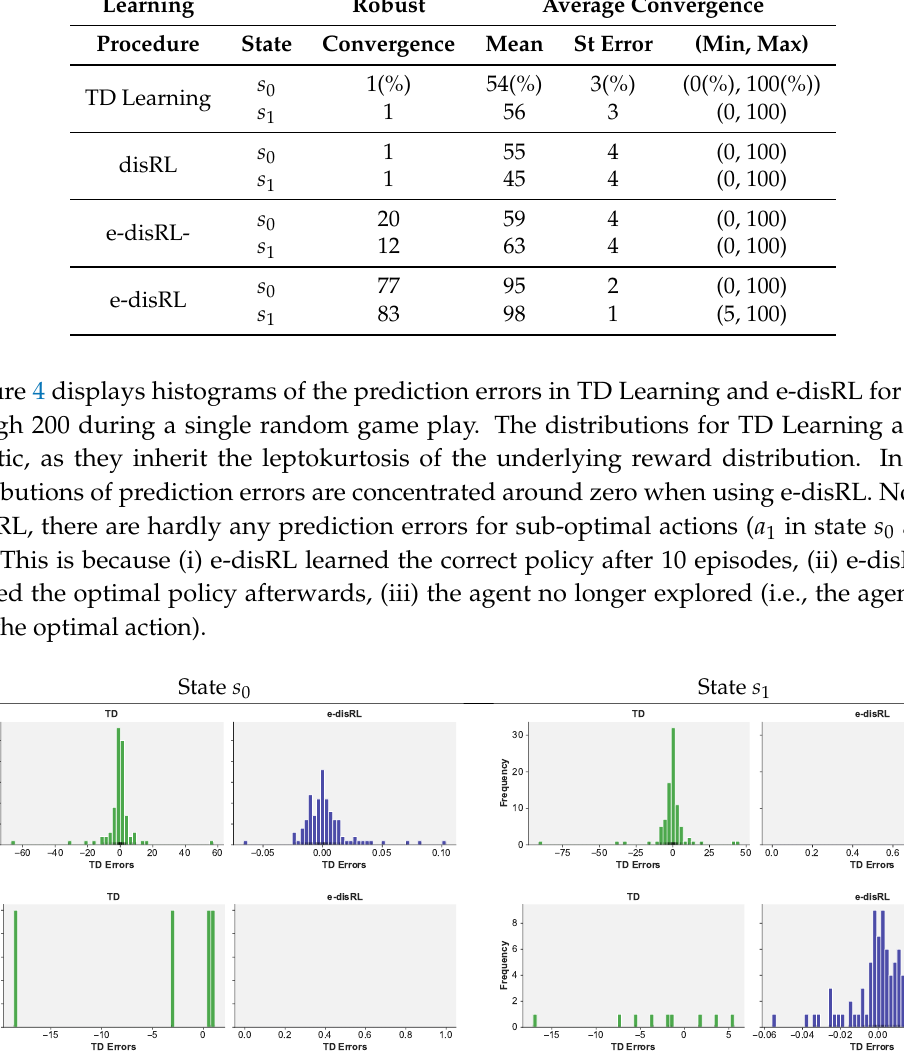
Figure 4. Prediction error histograms for all trials during episodes 11-200 of a single game play, TD Learning and e-disRL. There are no observations, and hence, no histograms, for e-disRL in state-action pair ( s 0 , a 1 ) , because the artificial agents reached the optimal policy at the end of the 10th episode, never switched policy afterwards, and stopped exploring. In one single trial, the e-disRL agent implemented the sub-optimal policy in state-action pair ( s 1 , a 0 )